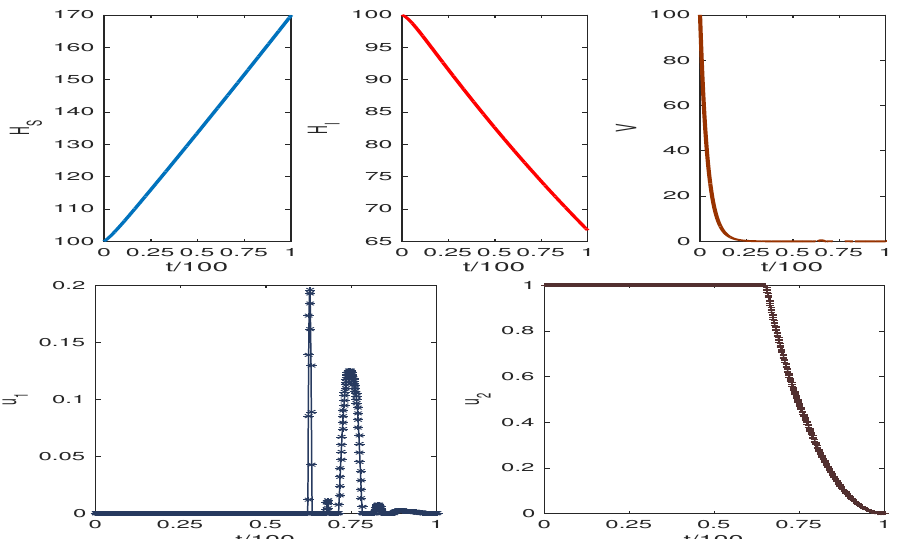
Figure 6. The graphs represent the effect of control and the variation of optimal control variable with the value of the fixed parameter taken from Table 1, and the weight constants are taken from Table 2.